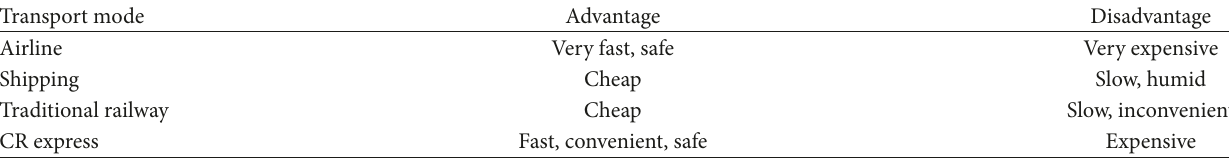
Table 4: Advantages and disadvantages of different modes of transportation (source: